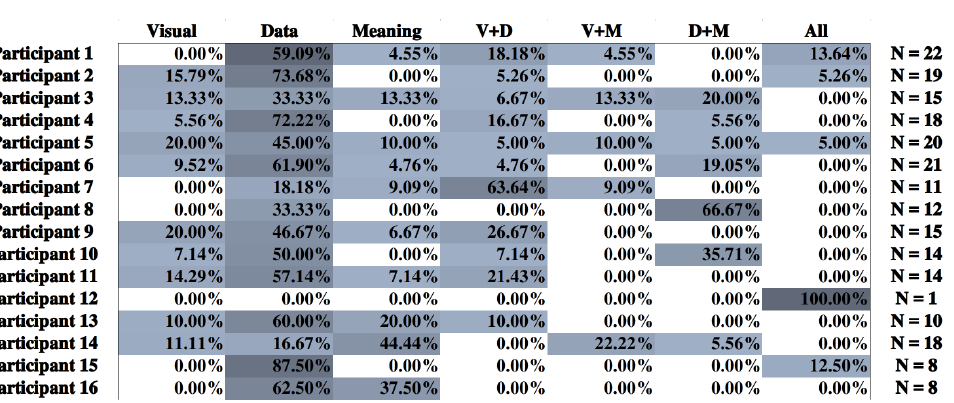
Figure 2. The coverage of our classification for the level of interpretation dimension, with N annotations per participant. Each row represents a participant. “V + D” means “visual and data”; “V + M” means “visual and meaning”; “D + M” means “data and